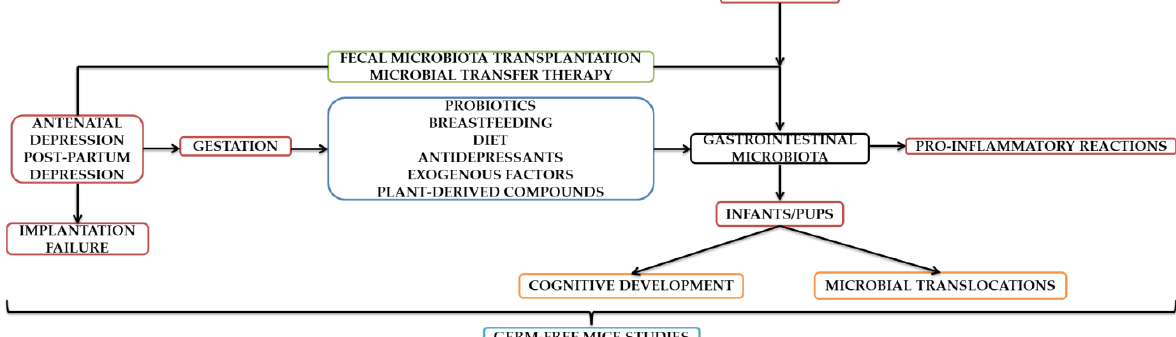
Figure 1. Schematic representation of the aspects contained in the Sections 3.1 – 3.6.